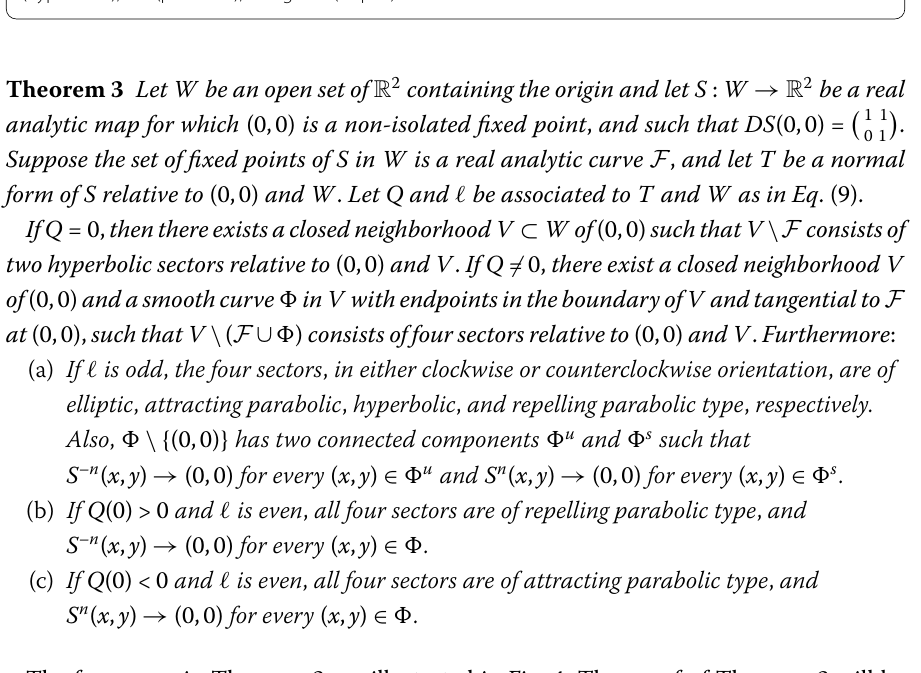
Figure 4 Dynamical behavior near a 1–1 resonant fixed point ( ¯ x , ¯ y ), according to Theorem 3; the black dot is ( ¯ x , ¯ y ). The thick curves through ( ¯ x , ¯ y ) are the invariant curves in Theorems A and B. The sectors appear in blue (hyperbolic), red (parabolic), and green